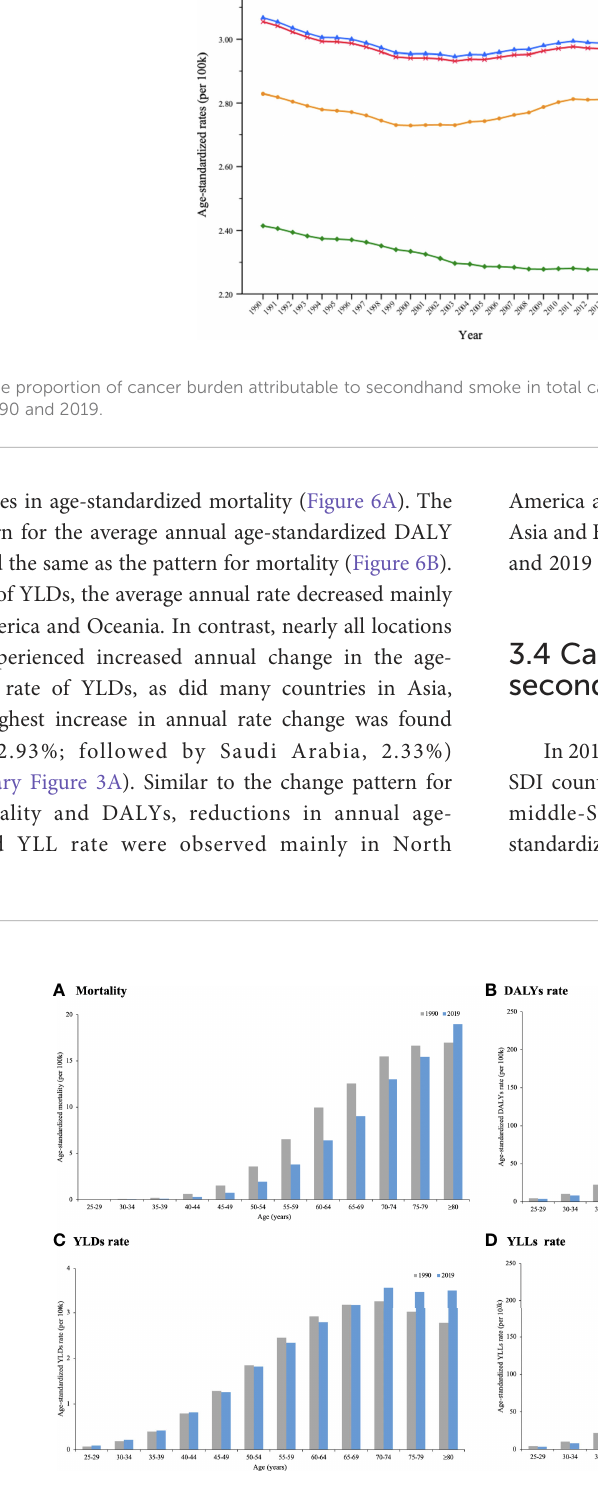
FIGURE 3 Global cancer burden attributable to secondhand smoke by age in 1990 and 2019. (A) Mortality; (B) DALYs rate; (C) YLDs rate; (D) YLLs